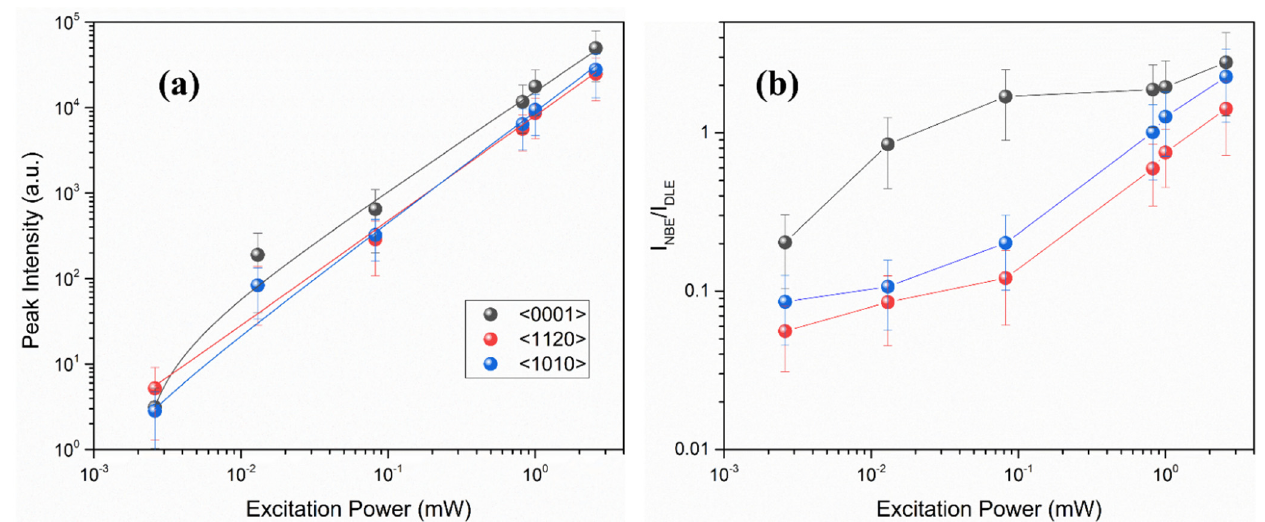
Figure 11. Excitation power-dependent ( a ) peak intensity of D o X, dashed lines are the fitting of experimental data using power law ( b ) the ratio of near band edge emission intensity to the deep level emission intensity for ZnO single crystal having different orientation. The peak intensity values used here have been extracted from Figure 10 without further processing.